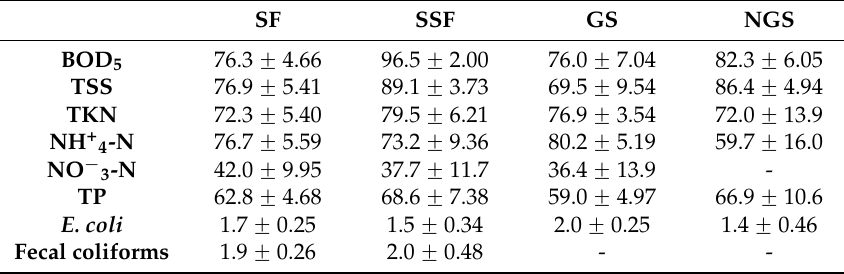
Table 3. Mean ( ˘ standard error) concentration reductions (CR, %), for five-day biochemical oxygen demand (BOD 5 ), total suspended solids (TSS), total Kjeldahl nitrogen (TKN), ammonium (NH + 4 -N), nitrate (NO ´ 3 -N), and total phosphorous (TP). Mean ( ˘ standard error) log reductions (LR) for E. coli , and fecal coliforms. The treatment performance is categorized by wetland design, surface flow (SF)